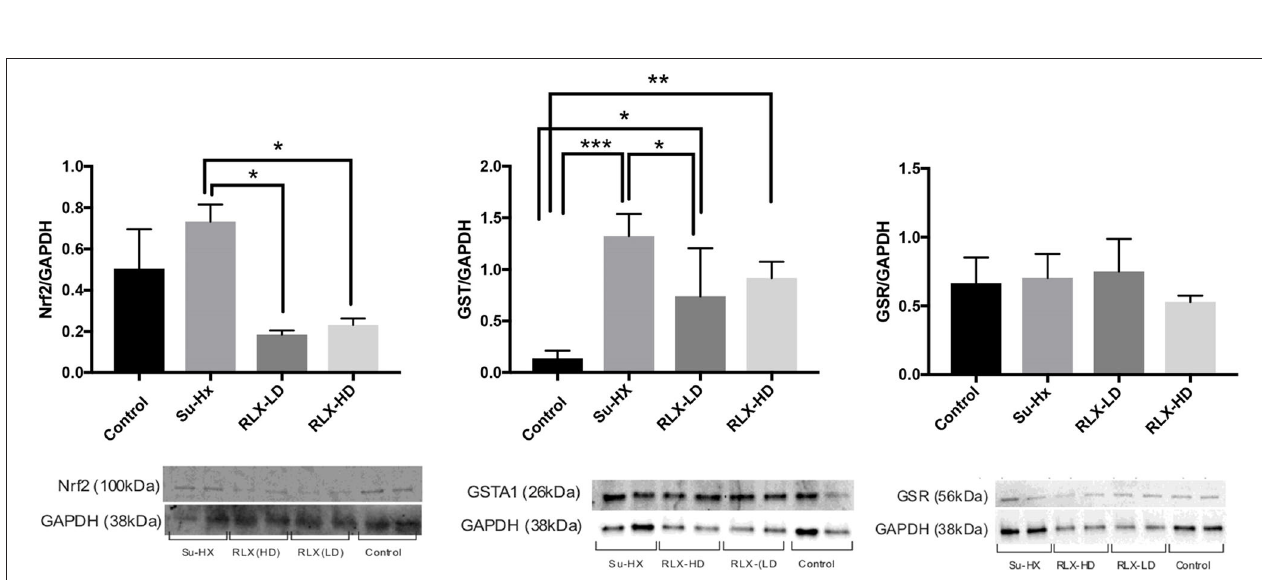
FIGURE 8 | Relaxin prevents oxidative stress in PAH hearts. Relaxin quantitatively prevents the overexpression of Nrf2 and Glutathione Transferase but not Glutathione Reductase. Each lane was loaded with 20 µ g of protein and the variability of loaded proteins was due to high protein levels in some tissue samples resulting in the addition of small volumes (2 µ l) in some lanes. Data were analyzed by ANOVA followed by Tukey’s multiple comparisons test. Only statistically significant differences are noted in the graph ( n = 4 animals per condition; each sample was run at least in duplicate in separate gels; significance: * p < 0.05; ** p < 0.01; *** p < 0.001).